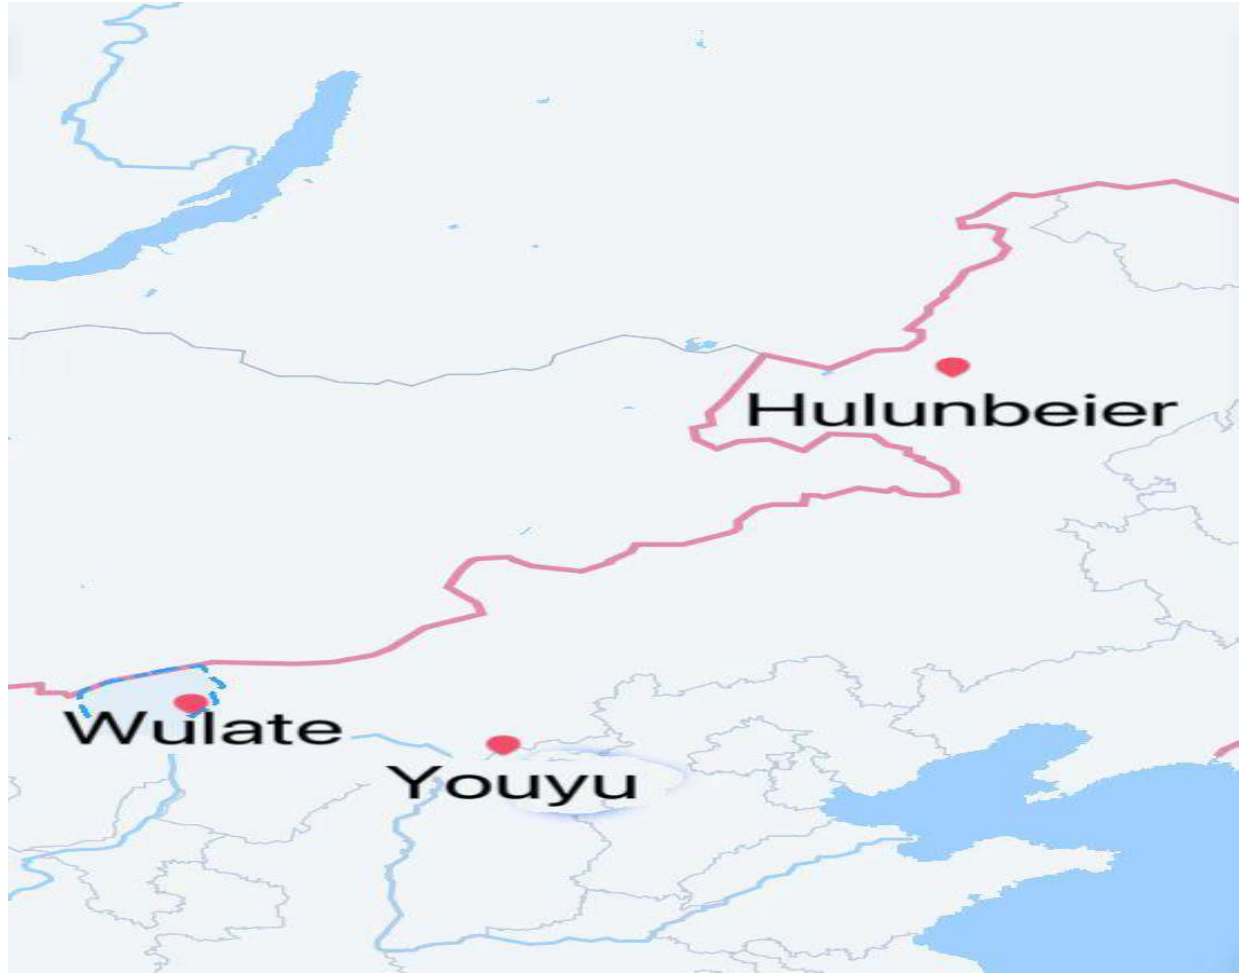
Figure 1. Distribution map of test sample points.